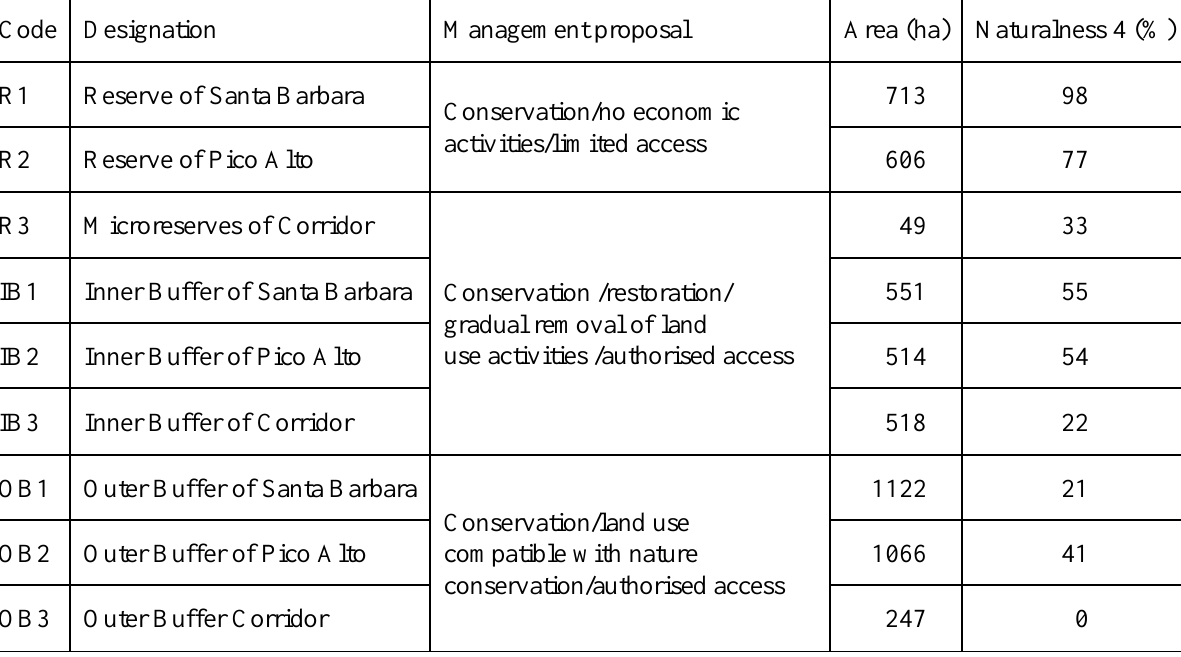
Table 1. Data for the areas defined in the management proposal established for Terceira peatlands.